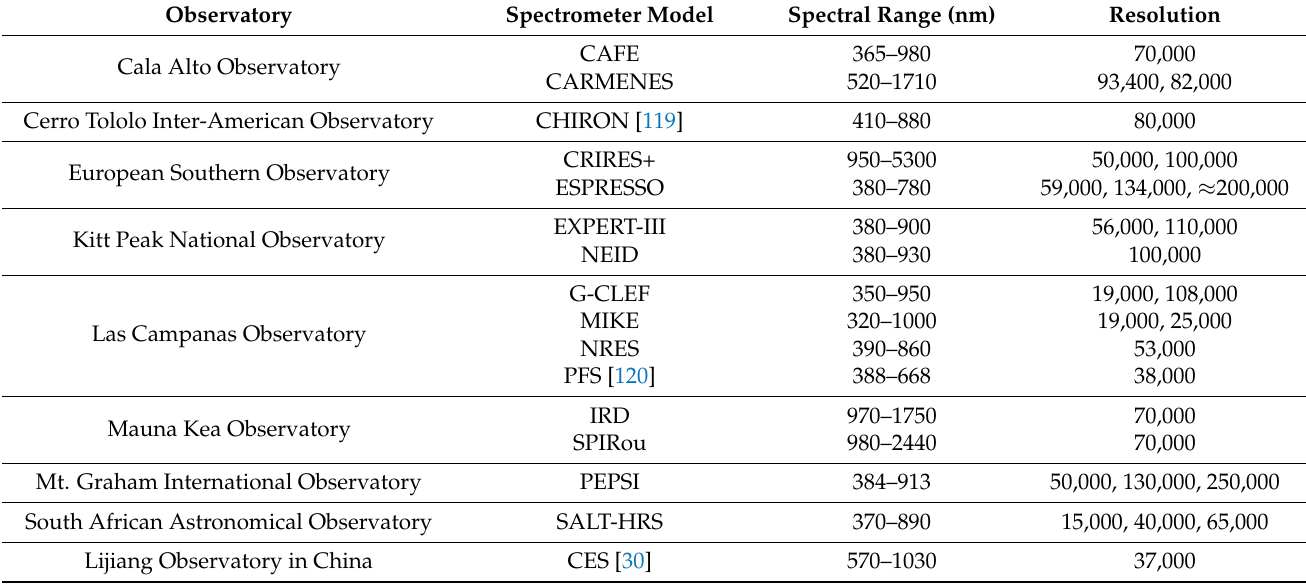
Table 1. Echelle spectrometers at